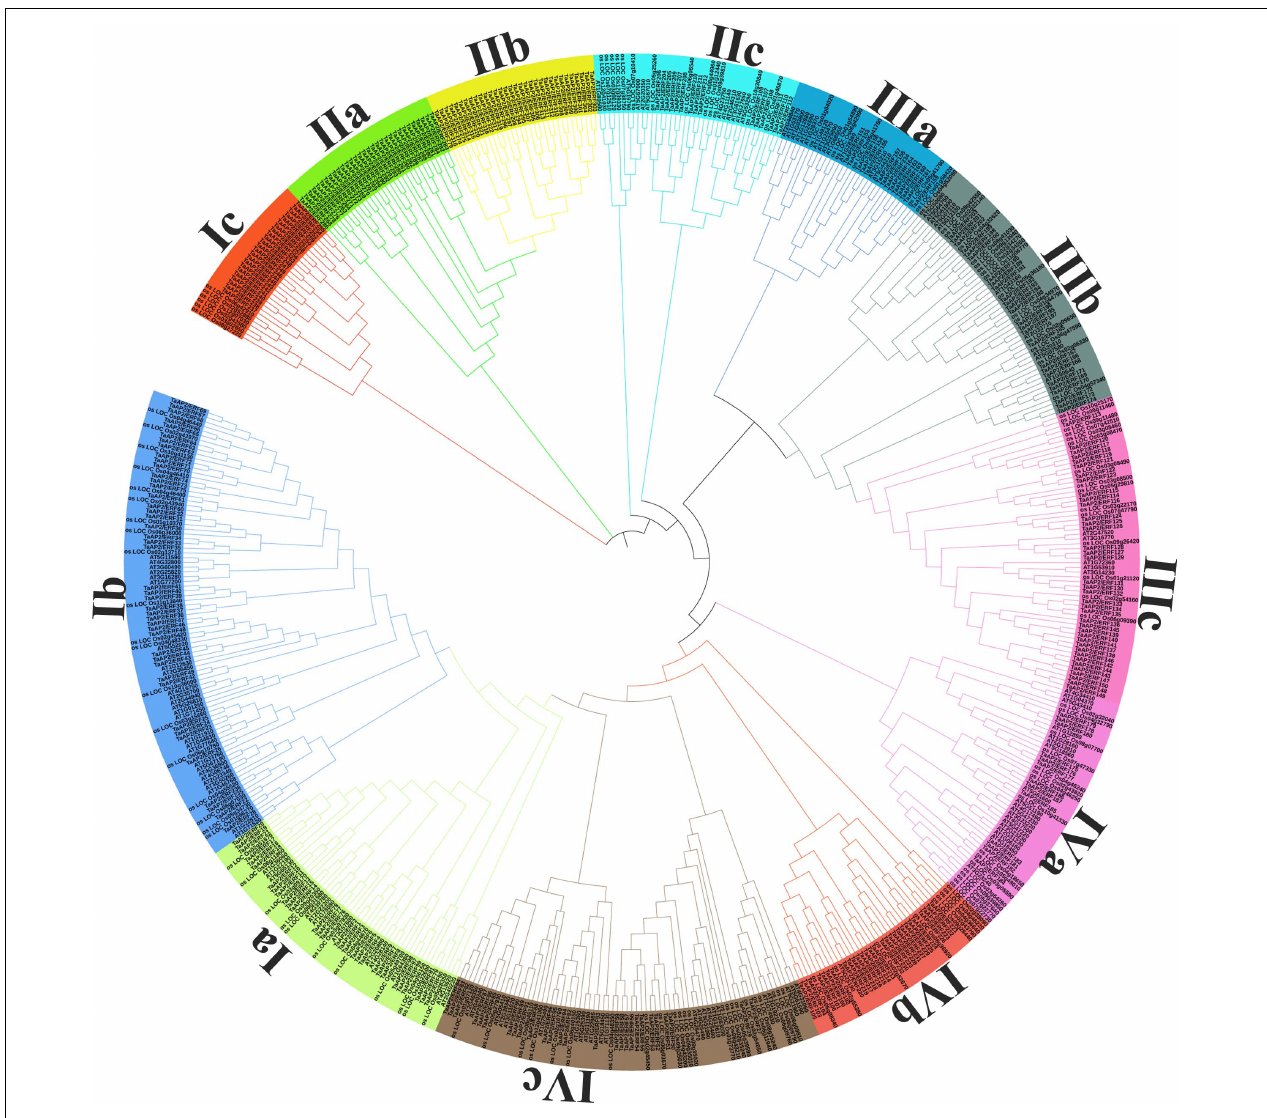
FIGURE 1 | Phylogenetic tree of AP2/ERF genes in Wheat, Rice, and Arabidopsis . The Phylogenetic tree was constructed with iTOL software by using the neighbor-joining